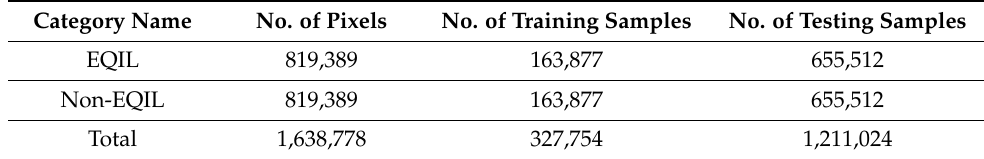
Table 2. Samples generated from the EQIL inventory of the Wenchuan